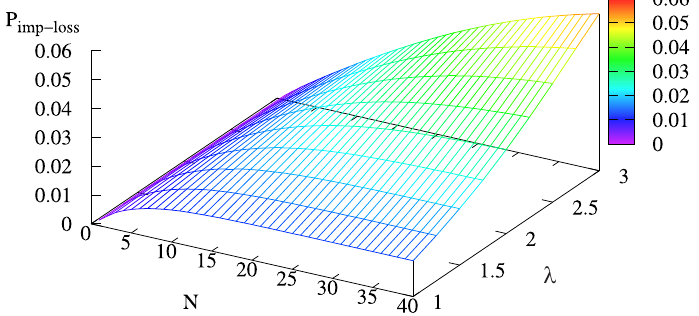
Figure 8. Dependence of the probability P imp − loss on N and λ